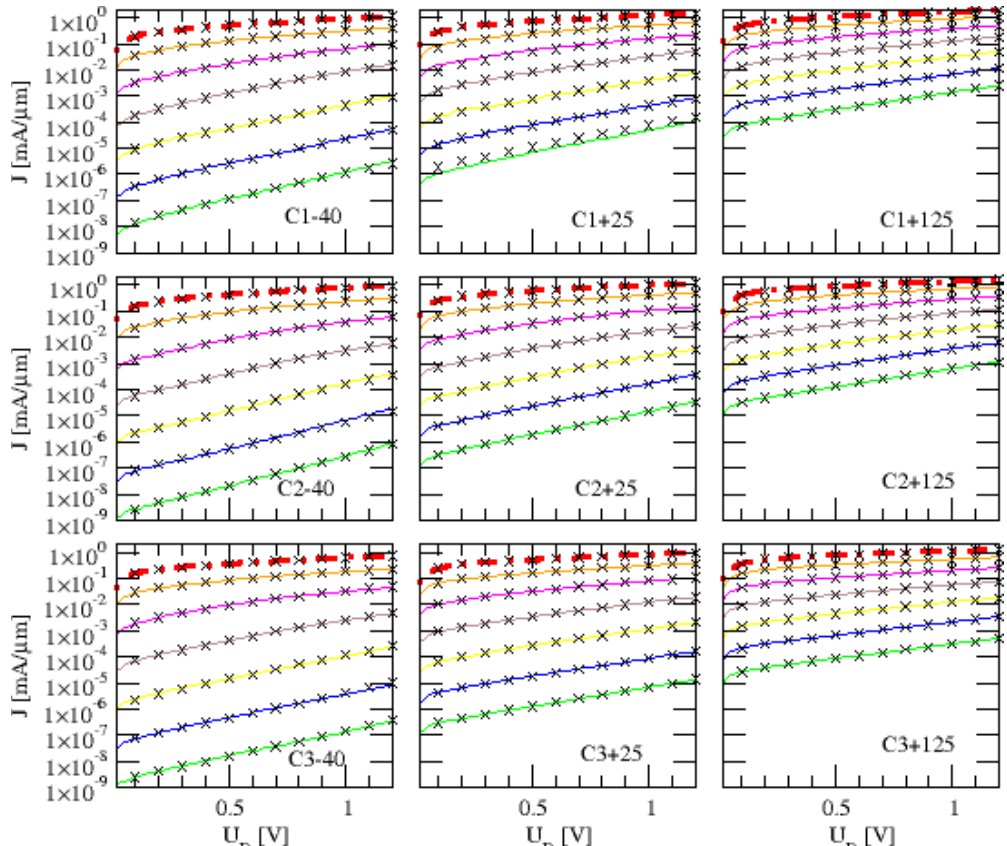
Figure 3. Experimental output traces J exp for the C-transistors in the OFF-state regime in logarithmic scale: upper row C1, middle row C2, left column environment temperature T = 233 K, middle column T = 298 K and right column T = 398 K; U G = 0 V (green), 0.1 V (blue), 0.2 V (yellow), 0.3 V (brown), = 0.6 V (red, close to linear threshold trace). Theoretical results 0.4 V (magenta), 0.5 V (orange) and U th G J cal according to (10) in black